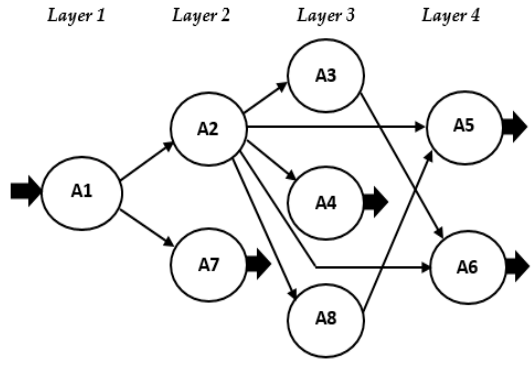
Figure 6. Ordered graph-scheme OGSA.